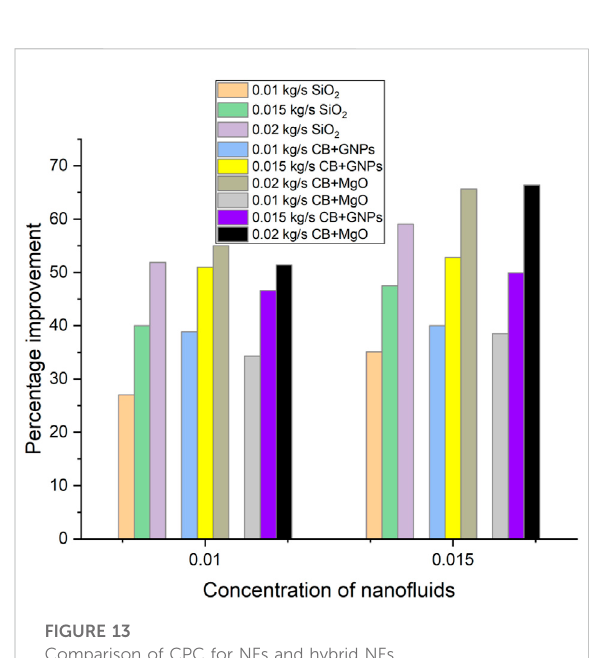
FIGURE 13 Comparison of CPC for NFs and hybrid